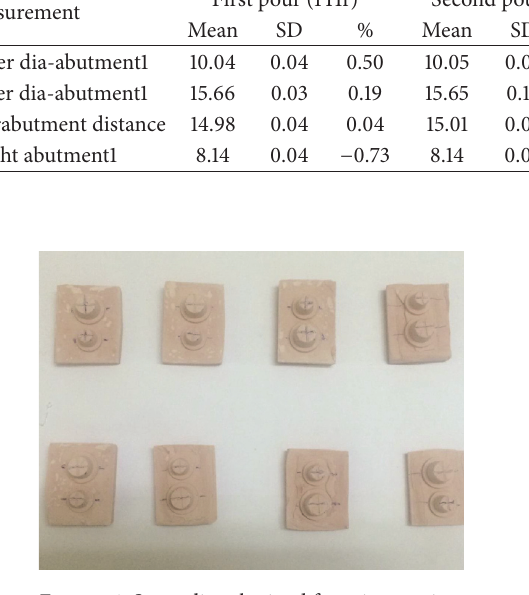
hypochlorite (1 : 10) immersion for 3 minutes. The polyether impressions were disinfected with sodium